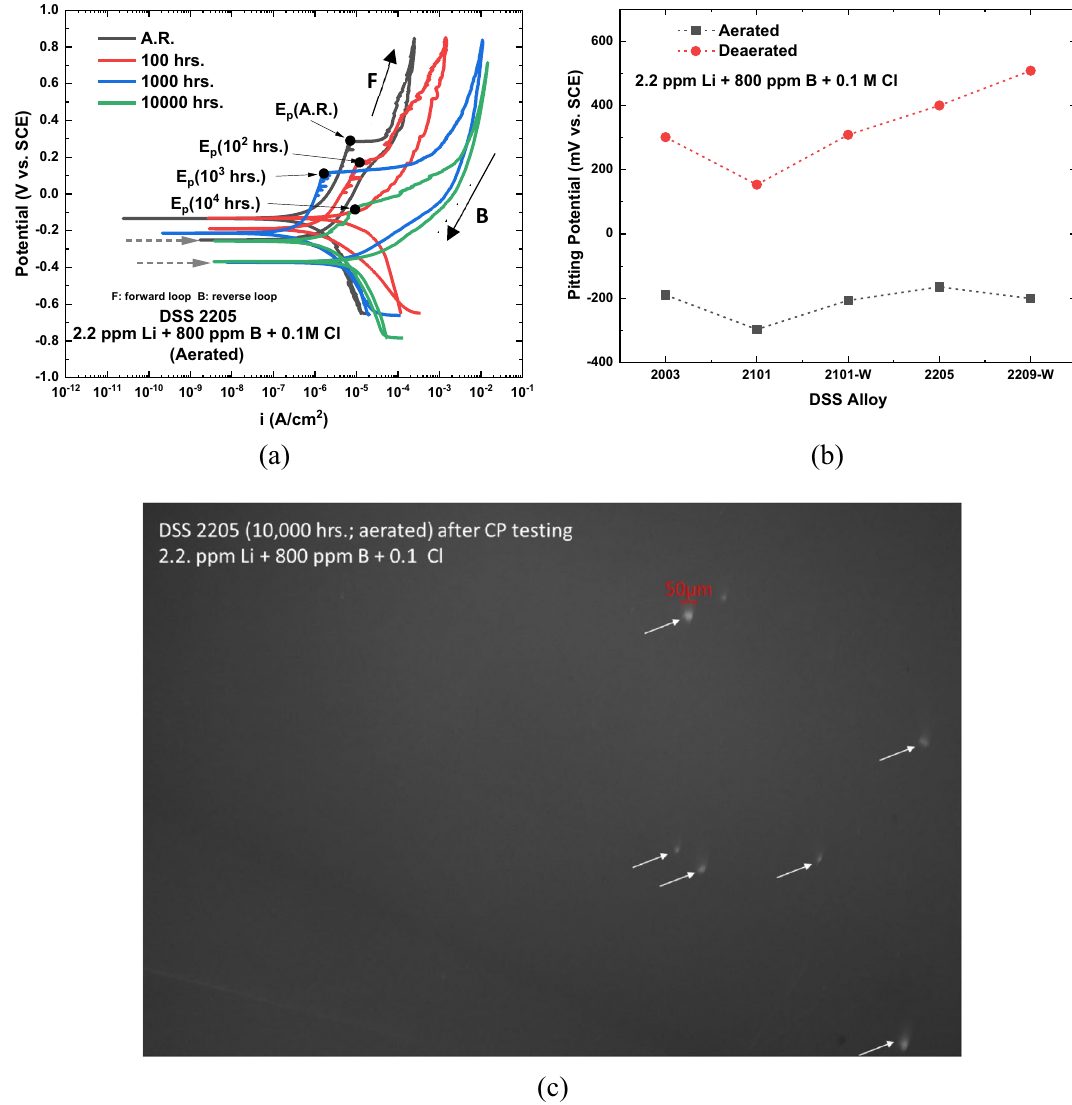
2205 for 10,000 h aged samples. c Optical micrograph of the DSS Fig. 10 a CP plots for DSS 2205 with increasing thermal aging time 2205 aged for 10,000 h (aerated); arrows indicate pits that formed exposed to base electrolyte (2.2 ppm Li, 800 ppm B) with chloride, after the CP showing a decrease in pitting potential ( E ) values with increasing p aging duration. b Pitting potentials of aerated and deaerated DSS